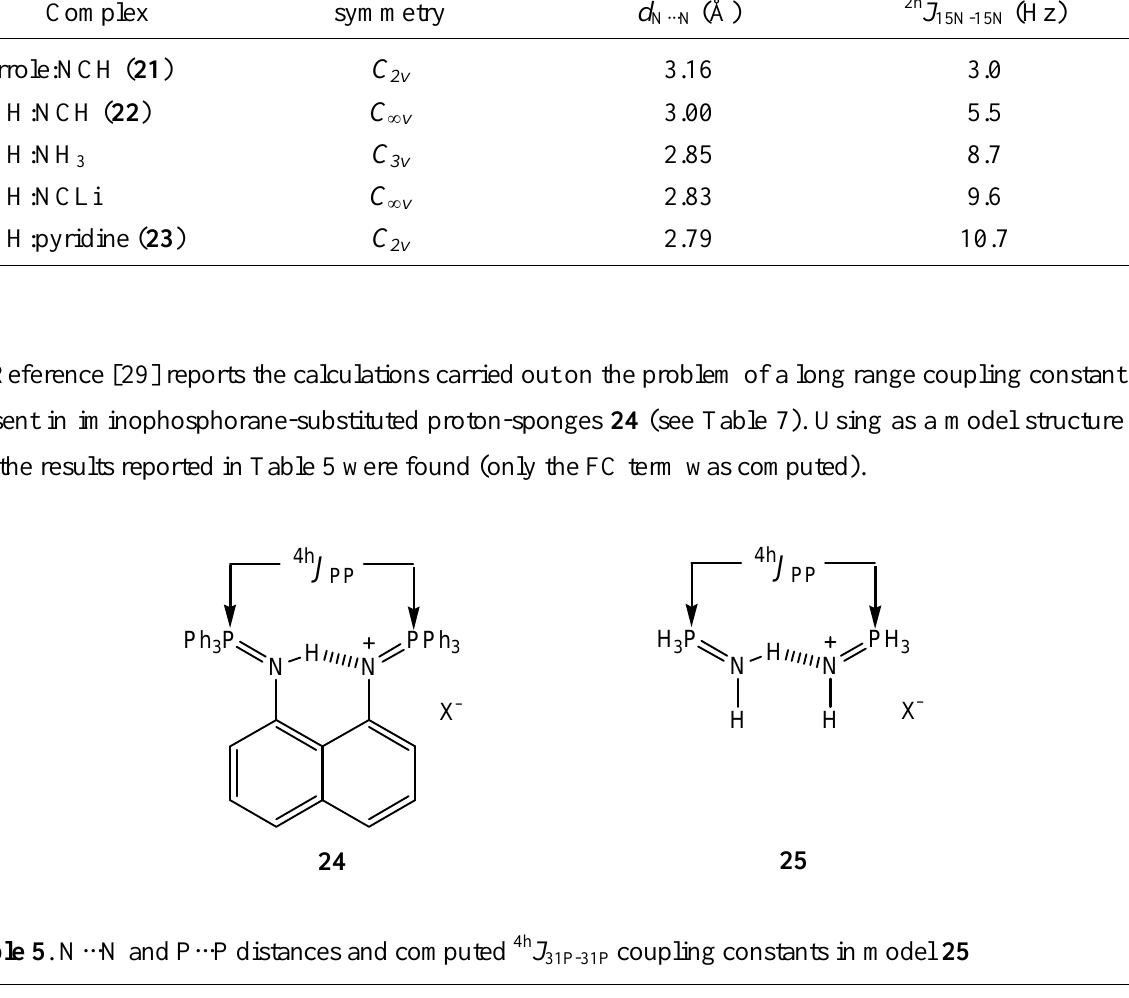
Table 4 . Equilibrium N···N distances, symmetry and 2h J Complex symmetry